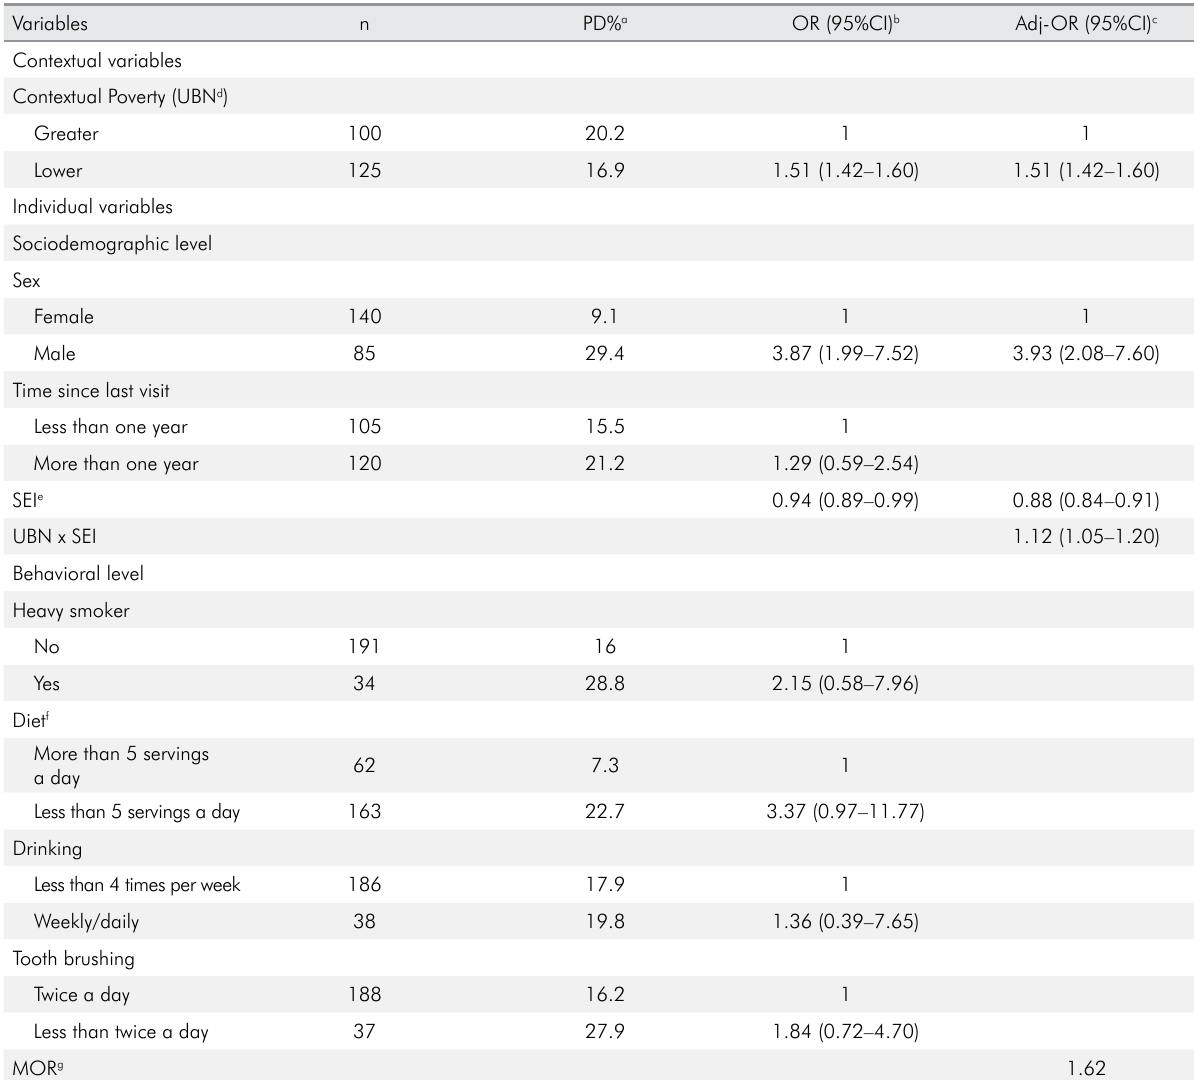
Table 1. Prevalence, and unadjusted and adjusted OR between periodontal disease (PD) and risk factors in the 35–44 age group.